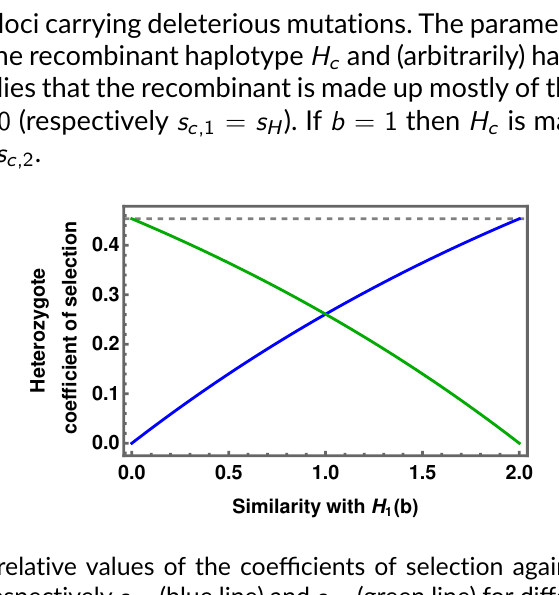
Figure B1 – The relative values of the coefficients of selection against heterozygotes H c H 1 and H c H 2 , respectively s c ,1 (blue line) and s c ,2 (green line) for different values of pa- rameter b (See Eq. B1. The dotted line represents s H , the coefficient of selection against